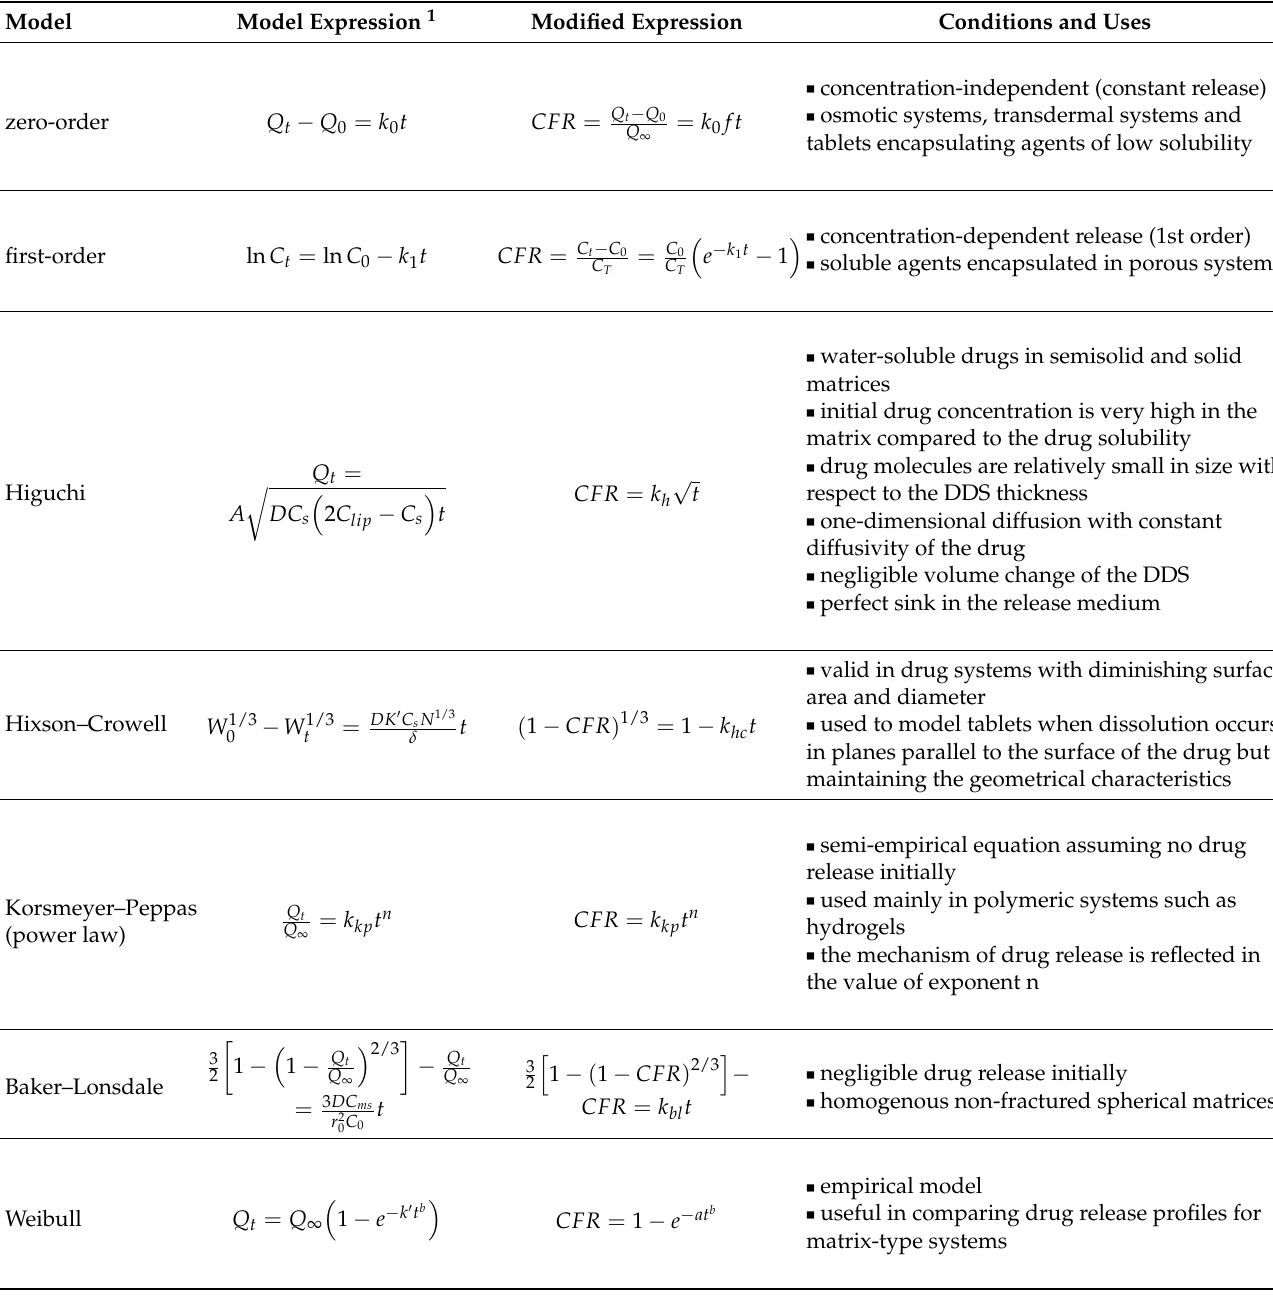
Table 1. The advantages and disadvantages of drug delivery trigger mechanisms.